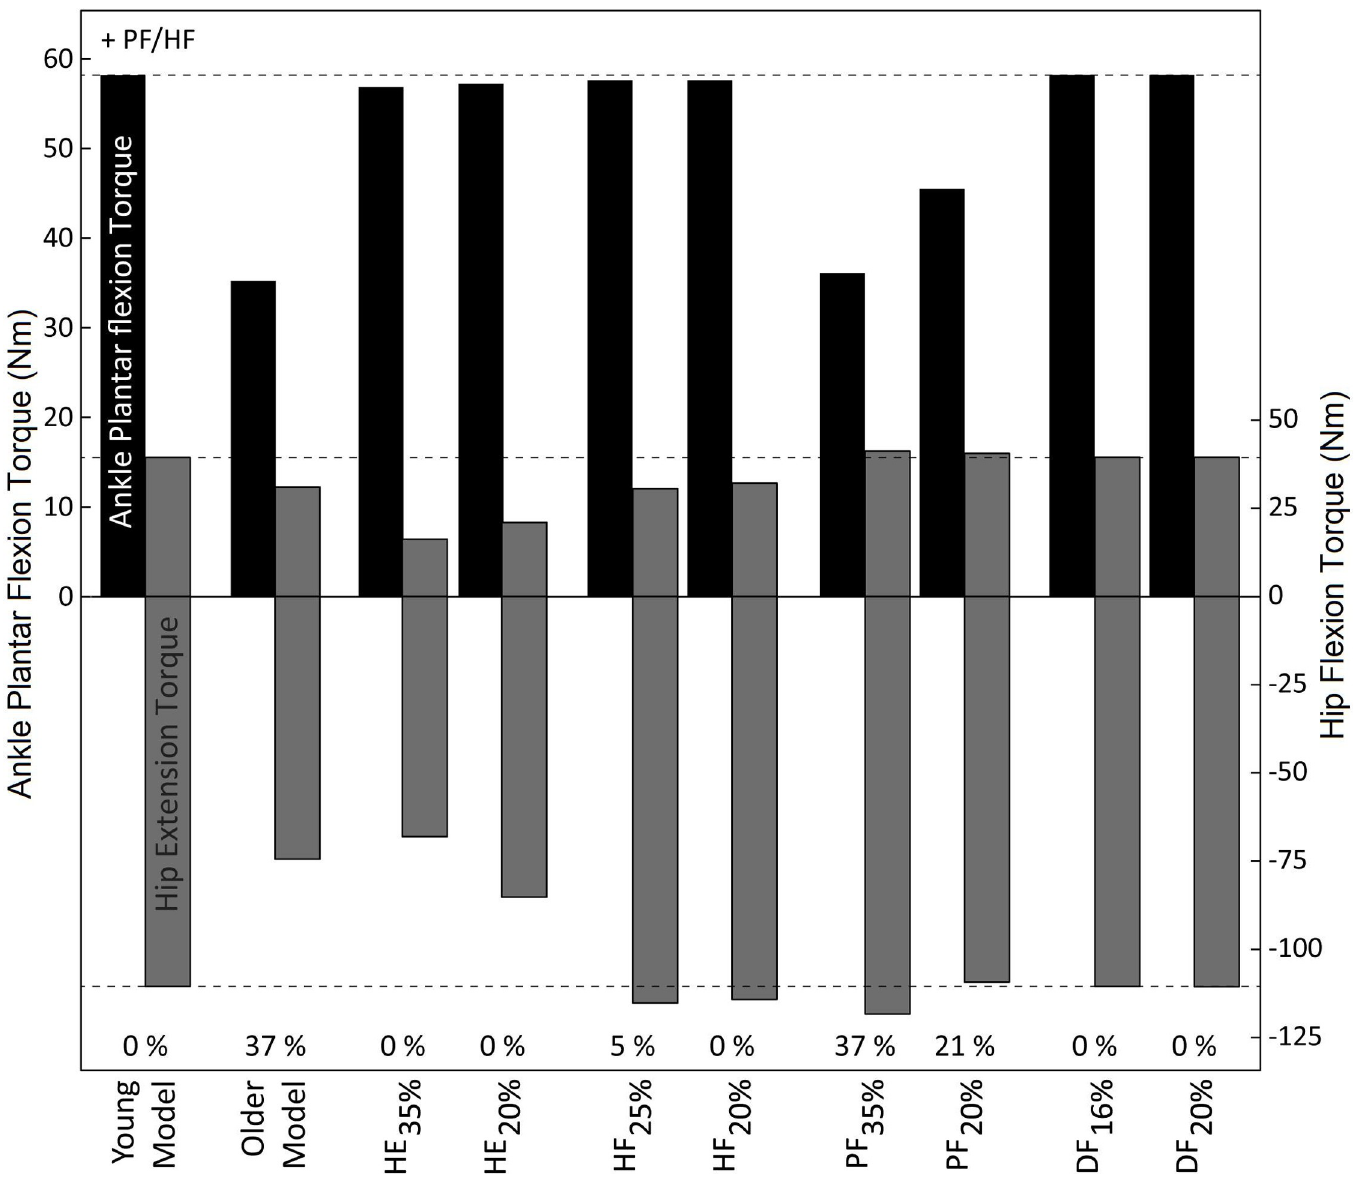
Fig 7. Peak joint torques at maximal platform displacement for young and older model, and all cases of strength loss. The top of the bars indicate peak ankle plantar flexion/hip flexion torque, and the bottom of the bars indicate peak dorsiflexion/hip extension torque. The percentages at the bottom represent the percent reduction in maximal platform displacement compared to the young